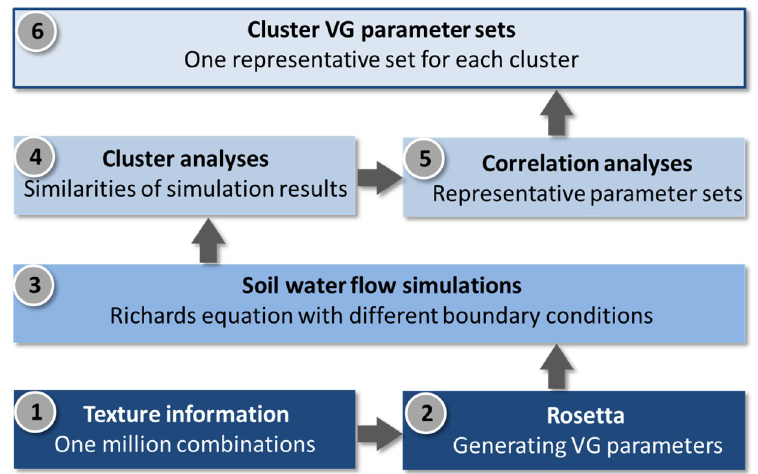
Figure 1. General procedure of soil classification by means of their hydraulic behaviour.